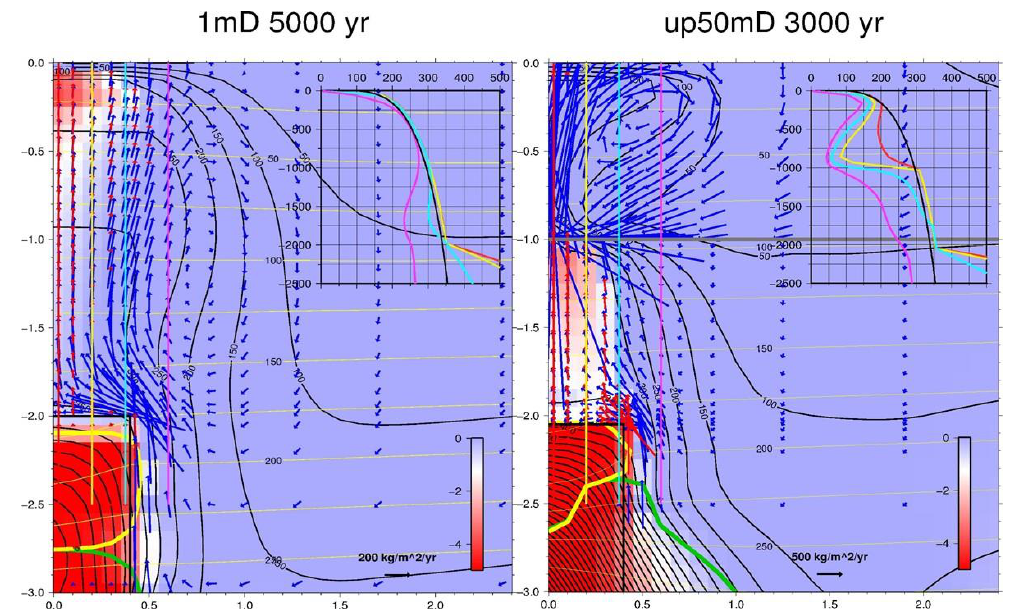
Figure 15. Two-dimensional modelling of thermo-hydraulic states of geothermal systems developed after the emplacement of an 800 m wide “dike” intrusion extending up to 2 km below surface into rocks with a temperature gradient of 100 °C/km (the scale of the horizontal and vertical axis is in km). To the left, is the system 5 ka after emplacement into rocks with the permeability 1 mD. The temperature (°C) is shown by black contours and the pressure (bars) by yellow contours. Phase conditions (water/steam) are shown by colours (light blue is pure water and dark red is almost pure steam, (actual scale 10 times the logarithm of water saturation). Mass flow (kg/m 2 /year) is shown by arrows (scale at the bottom of the figures), blue for water phase and red for steam phase. The graph shows temperature profiles from hypothetical wells at different distances from the centre of the intrusion (related by colour) in the upper-right corners. The thick yellow line marks region of superheated steam and the green line a region with supercritical conditions. To the right, is shown a thermo-hydraulic situation 3 ka after an intrusion is placed in a host rock of permeability 1 mD, underlying a 1 km thick pile (thick grey line) of much higher permeability (50 mD in this case). The figure to the left shows the developed geothermal system 5 ka after the dike injection into a host rock with a permeability of 1 mD. The figure shows a convecting two-phase geothermal system with up-flowing water and steam above the intrusion and a down flow of colder water to the sides down to the heat source. The panel in the upper-right corner shows calculated temperature profiles for hypothetical wells. Wells within the range of the dike (red and yellow) have temperature profiles corresponding to the boiling point curve (boiling point temperature vs. depth curve), while wells at the edge of or outside the dike (light blue and purple) roughly follow the boiling point curve at shallow depths but show temperature inversion at greater depths due to the in-flow of colder water towards the heat source.